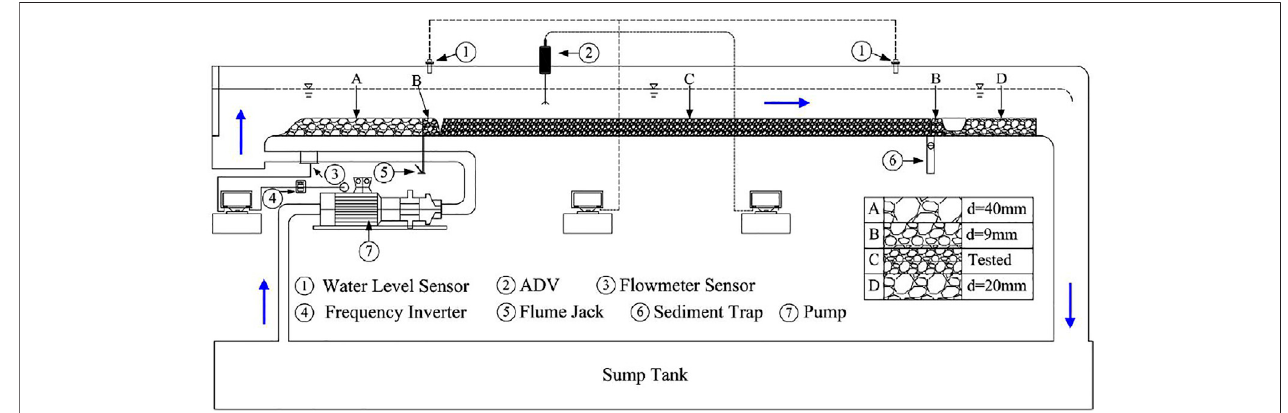
FIGURE 1 | Schematic representation of fl ume channel and experimental